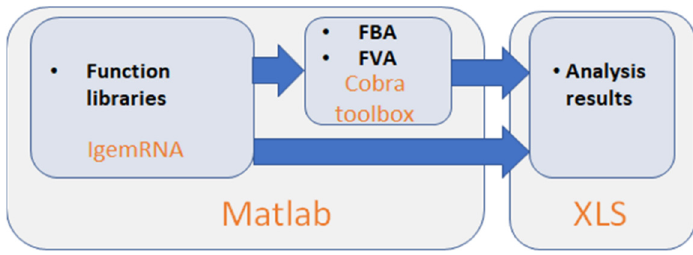
Figure 1. IgemRNA toolbox architecture scheme.